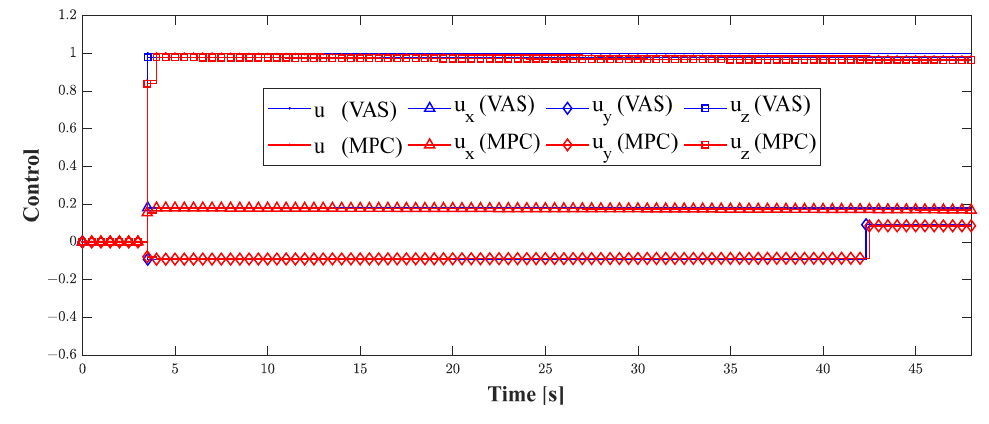
Figure 13. Control profiles of Example